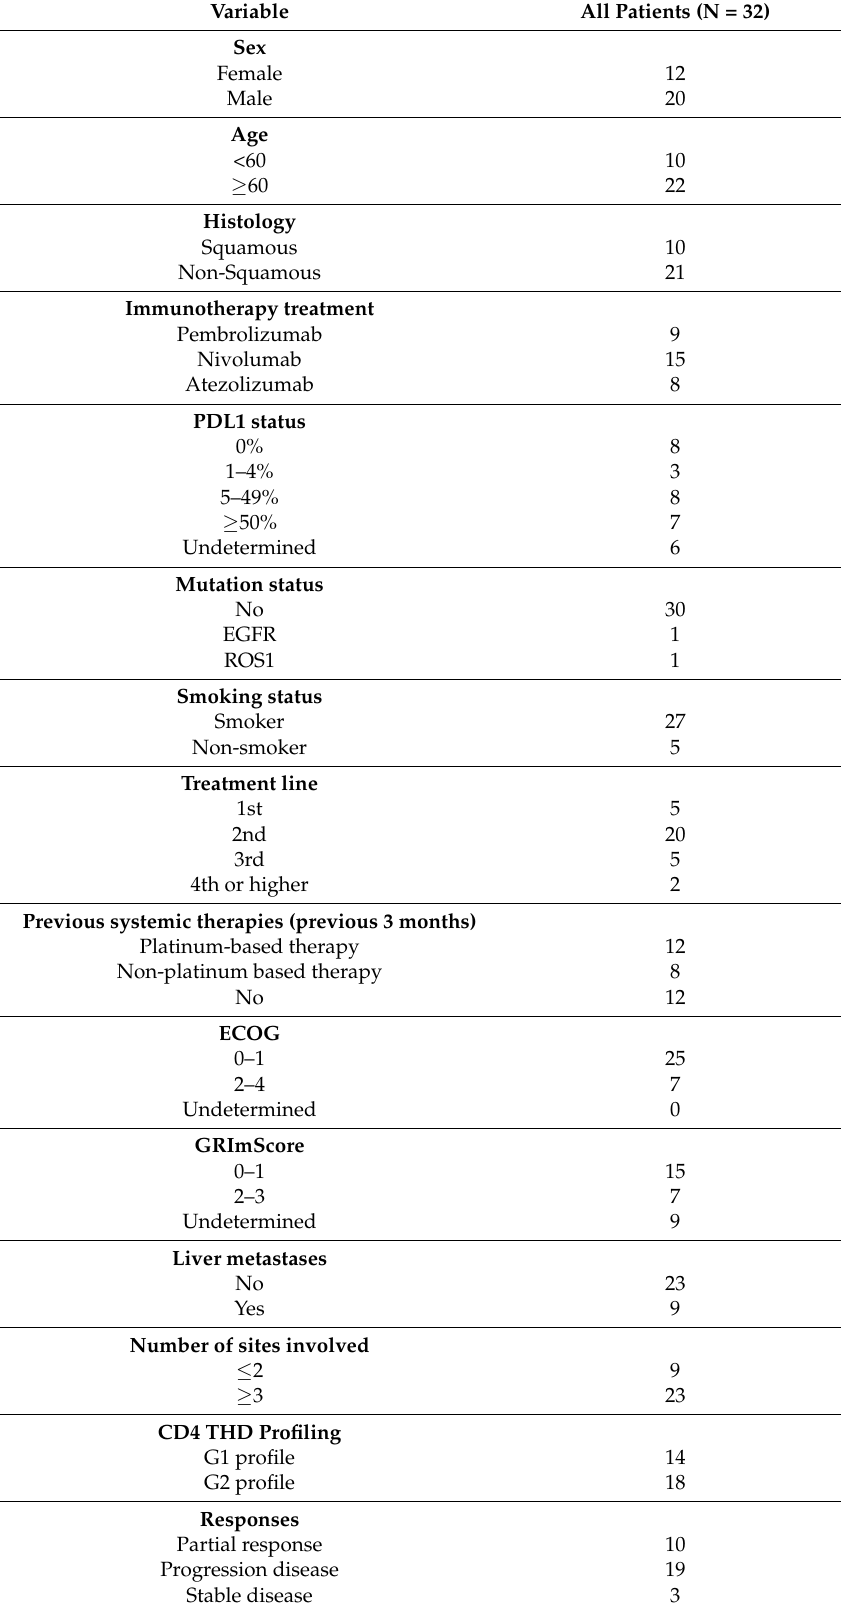
Table 1. Baseline characteristics of patients involved in the